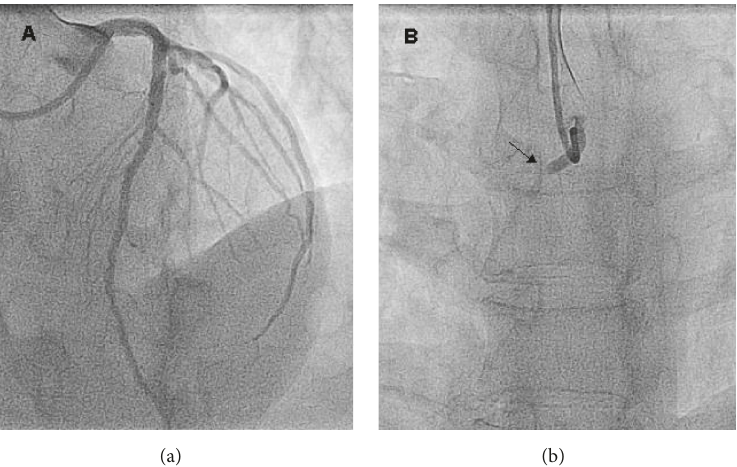
Figure 2: Coronary angiography. (a) Normal left coronary artery; (b) proximal occlusion of anomalous right coronary artery (black arrow) originating in the left Valsalva